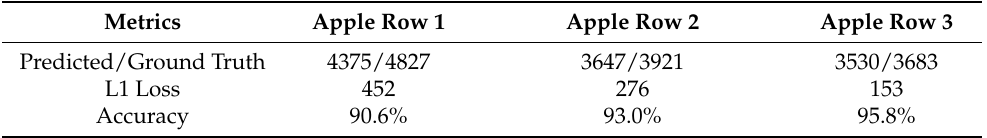
Table 6. Results of the proposed pipeline running on a video clip of three neighboring rows of apples. We observed consistent performance across the three rows, with accuracy varying between 90–95%. This is consistent with the performance shown on the smaller scale apple detection in the earlier